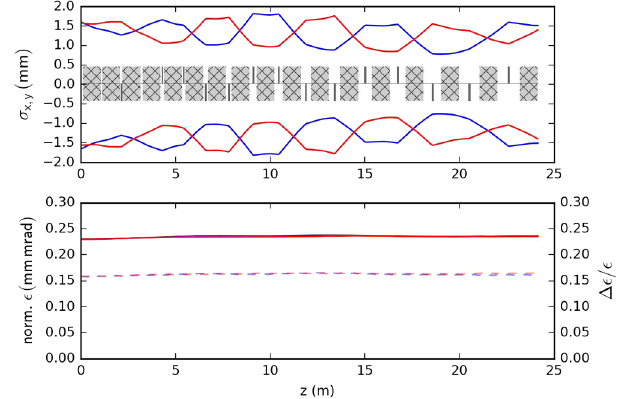
FIG. 5. rms beam envelope for the second pass using 6D waterbag initial distribution with 20 mA bunch current.